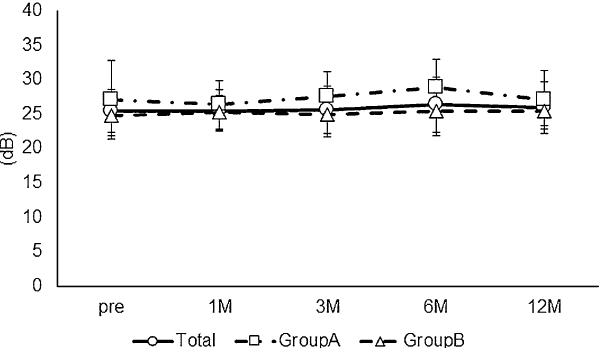
Figure 2. The time course change in central sensitivity on microperimetry (CS-MP3). The mean preoperative CS-MP3 (dB) was 25.4 ± 4.1 in all eyes, 27.1 ± 3.3 in Group A, and 24.8 ± 4.3 in Group B. At each postoperative time point, the CS-MP3 was 25.5 ± 3.5, 25.6 ± 4.8, 26.4 ± 5.2, and 25.9 ± 4.2, respectively, in all eyes, and 26.4 ± 3.6, 27.6 ± 2.9, 28.9 ± 2.3, and 27.1 ± 2.2, respectively, in Group A, and 25.2 ± 3.5, 24.9 ± 5.2, 25.4 ± 5.7, and 25.5 ± 4.8, respectively, in Group B. In all groups, the CS-MP3 at each postoperative time point was not statistically different from the preoperative CS-MP3 (Friedman’s test, p = 0.52, p = 0.10, p = 0.90, respectively,)